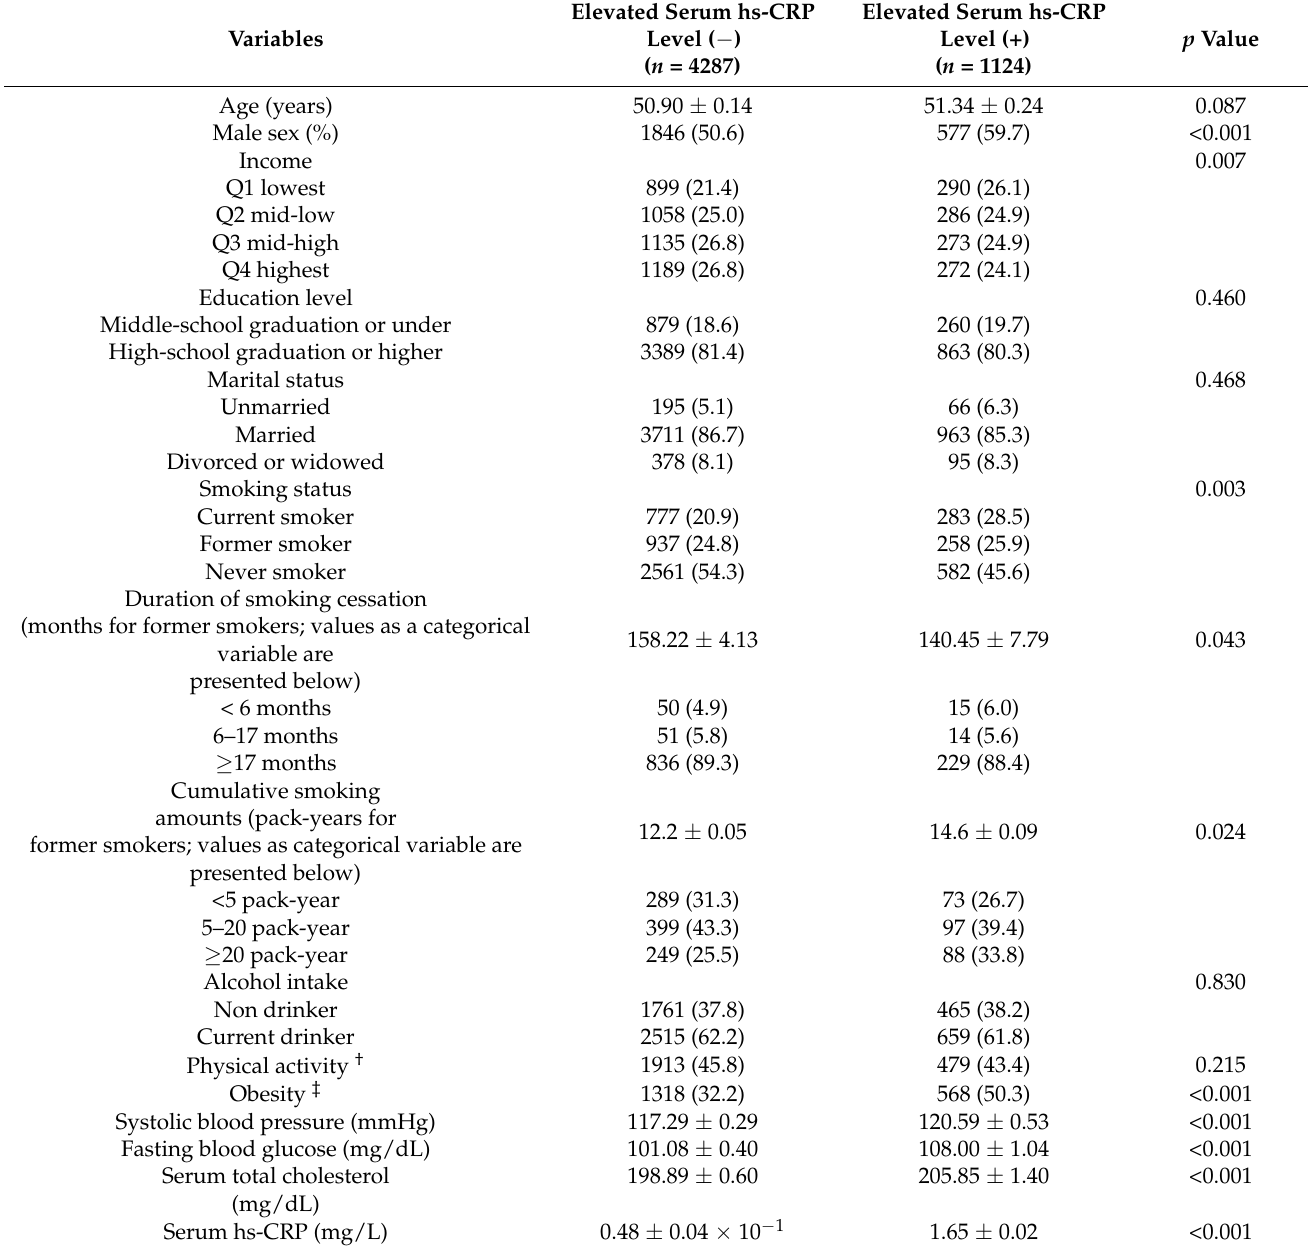
Table 1. Demographic characteristics according to the elevated serum hs-CRP level * in Korean